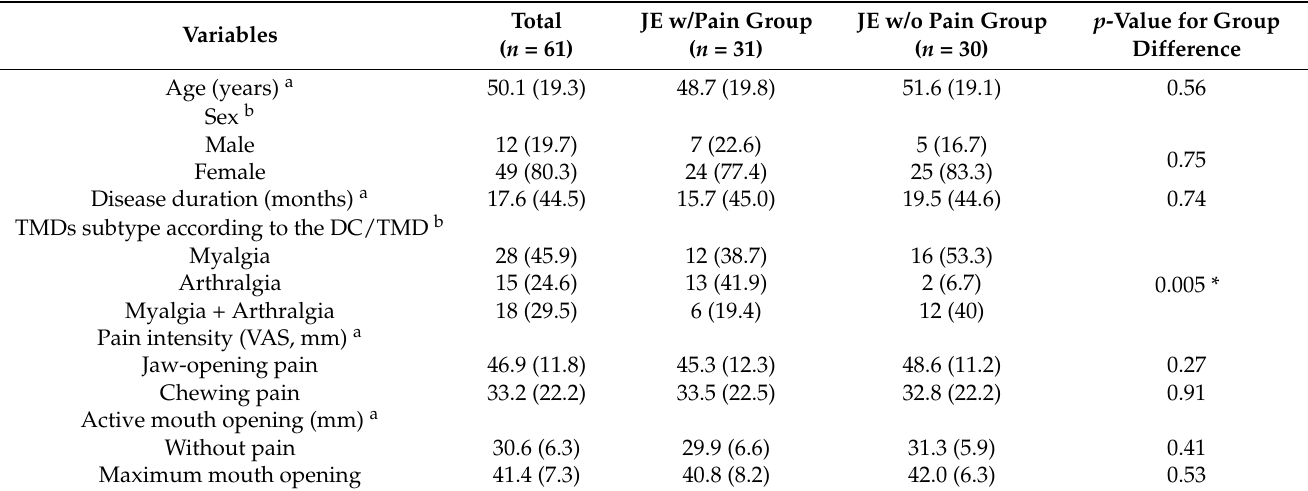
Table 1. Comparison of baseline demographic and outcome variables between the two